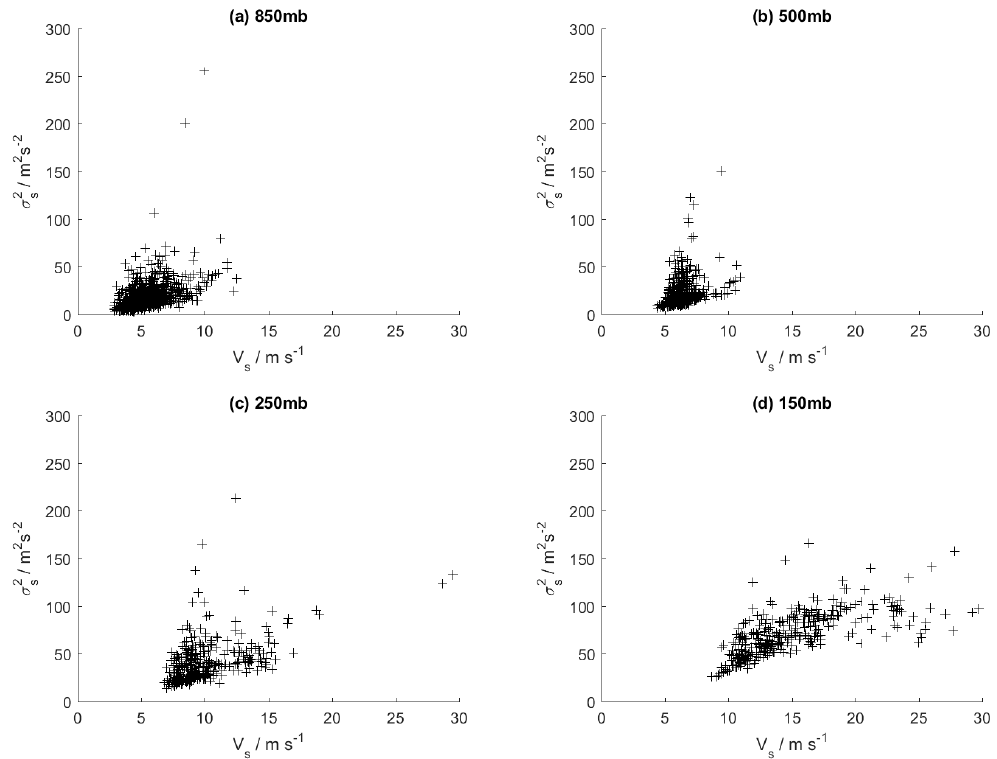
Figure 2. Scatters of σ 2 s vs. V s for four of the eleven standard pressure levels: ( a ) 850 mb; ( b ) 500 mb; ( c ) 250 mb; ( d ) 150 mb.